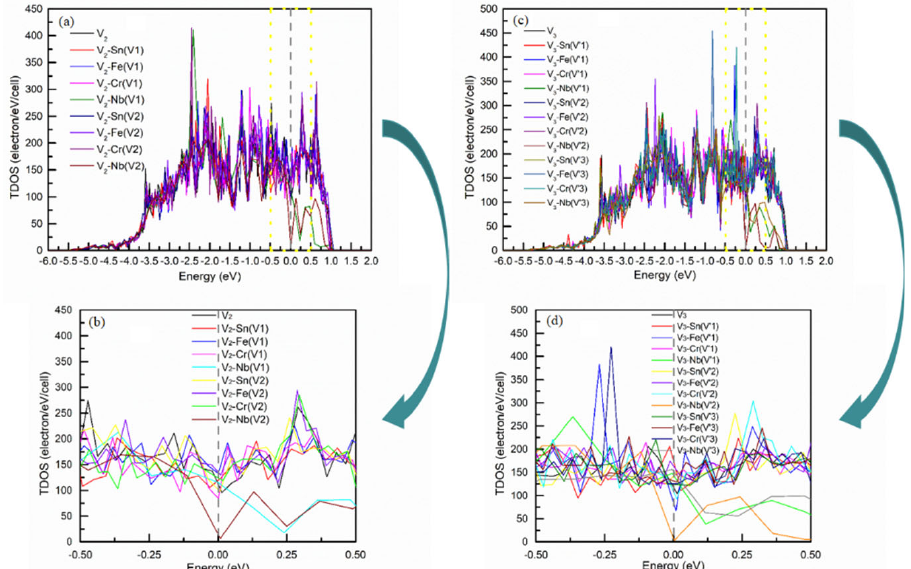
Figure 3. TDOSs of a different number of zirconium atom supercells with different sites for one vacancy ( a , b ), or two vacancies ( c , d ), and one alloying element (Sn, Fe, Cr, or Nb); where the silver line stands for the Fermi level.